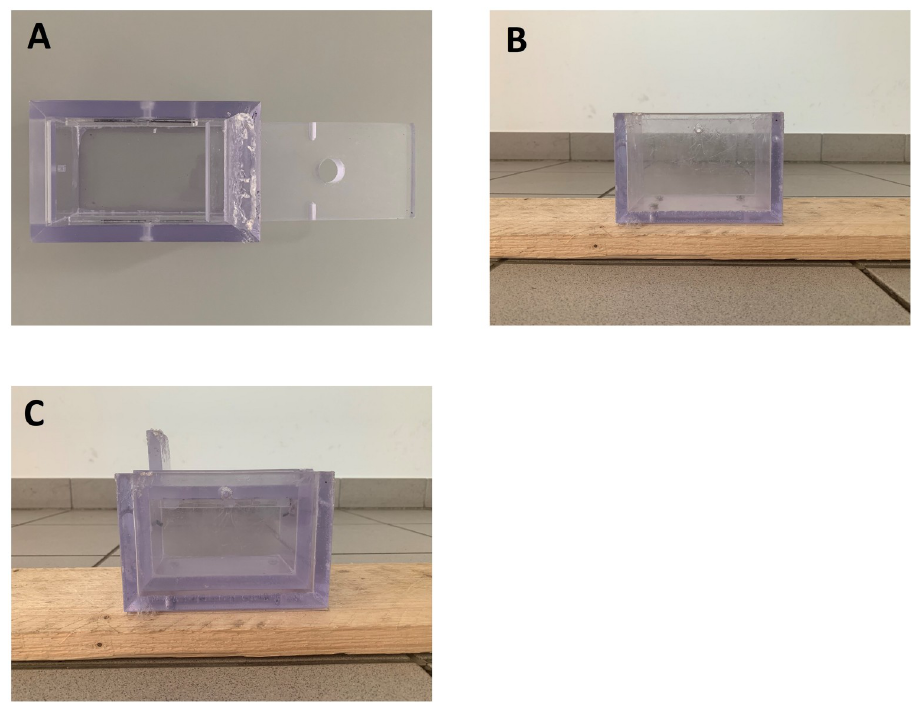
Fig 1. Photos of the box and impossible task apparatus. (A) Bird’s eye view of the box: there were three identical clear polycarbonate boxes with a hole in the centre of the sliding lid; (B) impossible task apparatus: a wooden plank with a clear polycarbonate box attached at the centre of it; (C) the beggar’s box was placed inside the impossible task apparatus and secured by sliding two nails through the walls of both boxes.